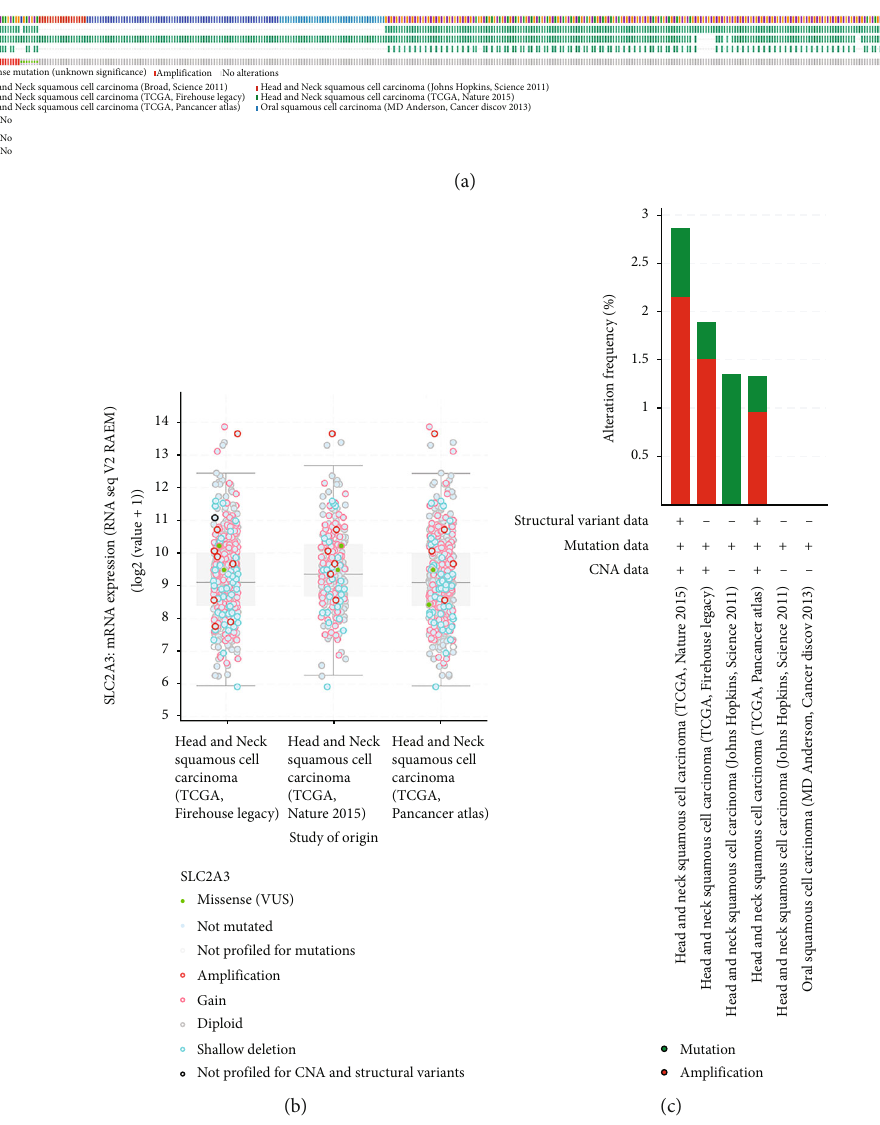
Figure 5: Genomic alterations of SLC2A3 in six data-sets investigated using the cBioPortal database. OncoPrint of SLC2A3 expression in HNSCC (a). SLC2A3 gene alteration types in HNSCC (b). Details of SLC2A3 gene alteration types in HNSCC